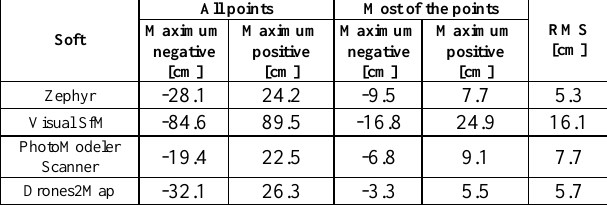
Table 8. The residuals of the roof UAS point clouds obtained by using different software